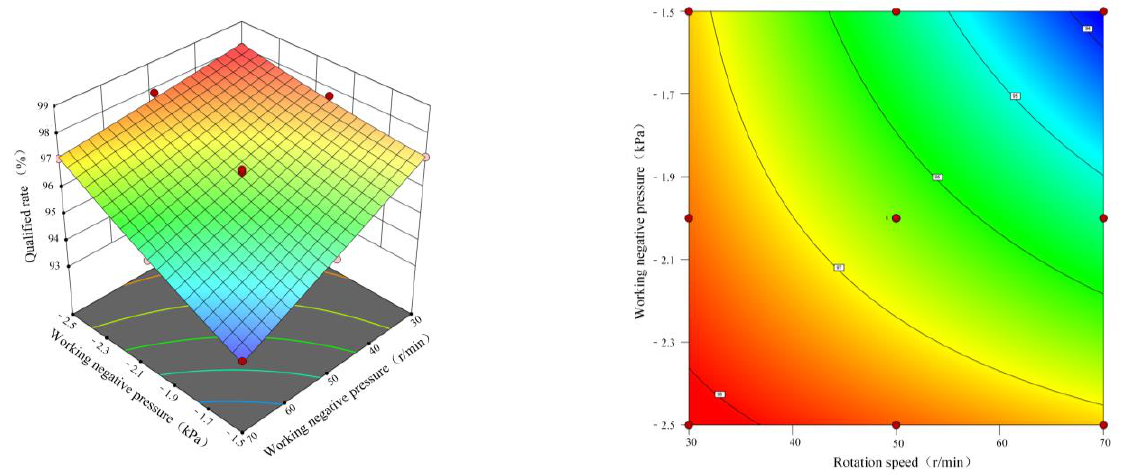
Figure 20. Response surface diagram of the hole number qualified rate.